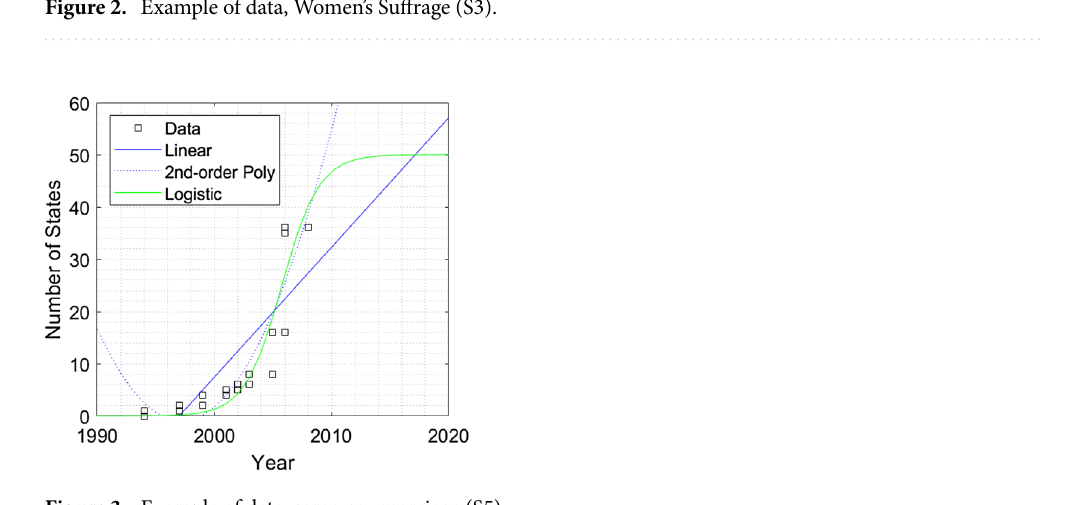
Figure 3. Example of data, same-sex marriage